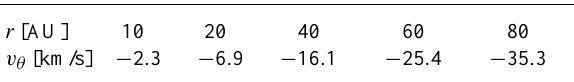
Table 2. Estimated relative density variation δρ/ρ 0 as a function of the solar distance in units of [AU], resulting in the ecliptic due to latitudinal solar wind velocity